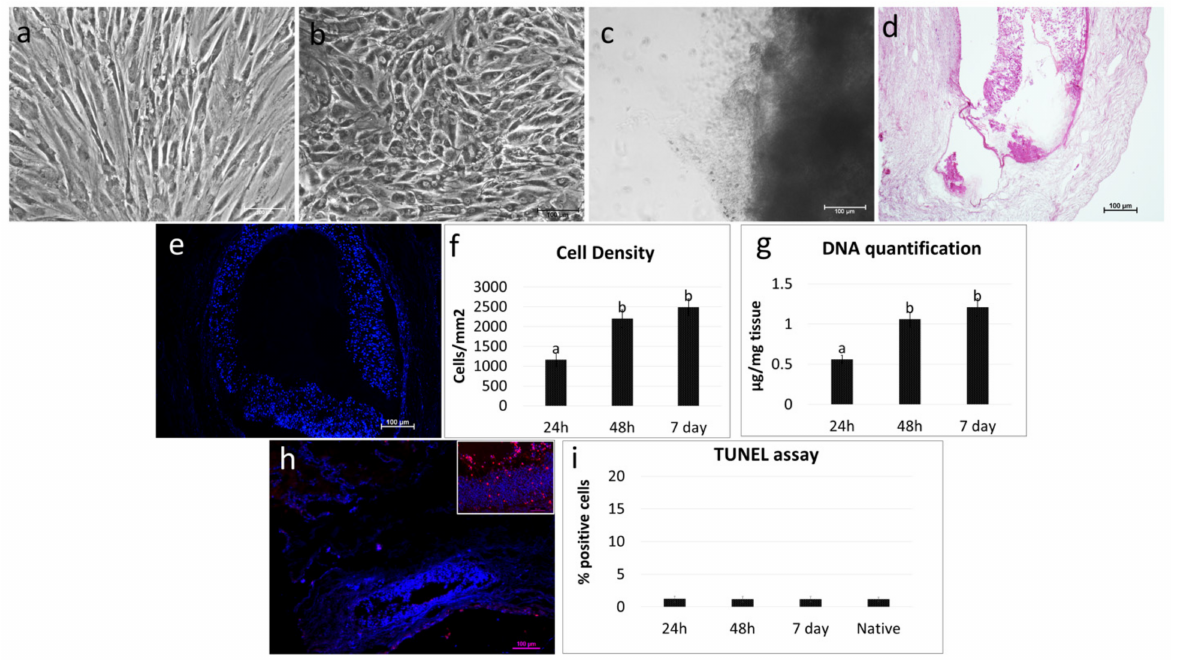
Figure 7. Repopulation of decellularized ovarian ECM-based scaffolds with hEpiE. ( a ) Representative image of human untreated fibroblasts showing the typical elongated shape. Scale bar = 100 µ m. ( b ) After 18 h of exposure to 5-aza-CR, cells displayed a round epithelioid aspect and became smaller in size with larger nuclei and granular cytoplasm. Scale bar = 100 µ m. ( c ) hEpiE adhered and migrated into the decellularized ECM-based ovarian scaffolds. Representative image after 7 days of culture. Scale bar = 100 µ m. ( d ) H & E staining demonstrated the presence of hEpiE in the ECM-based scaffolds. Scale bar = 100 µ m. ( e ) DAPI staining showed the positivity for nuclei. Scale bar = 100 µ m. ( f ) Cell density analysis indicated ECM-based scaffolds’ repopulation after 24 h, with a higher number of cells after 48h and 7 days of coculture. Data are expressed as the mean ± the standard error of the mean (SEM). a and b indicate statistically significant differences ( p < 0.05). ( g ) DNA quantification confirmed the presence of hEpiE in the ECM-based scaffolds after 24 h, with an increasing number of cells at 48h, which was steadily maintained at Day 7. Data are expressed as the mean ± the standard error of the mean (SEM). a and b indicate statistically significant differences ( p < 0.05). ( h ) Representative picture of the TUNEL assay showing positive cells in red. Nuclei were stained with DAPI (blue). Scale bars = 100 µ m and 50 µ m. ( i ) TUNEL-positive cell rates detected 24–48 hours and 7 days after seeding were comparable to those identified in the native tissues (native). Data are expressed as the mean ± the standard error of the mean